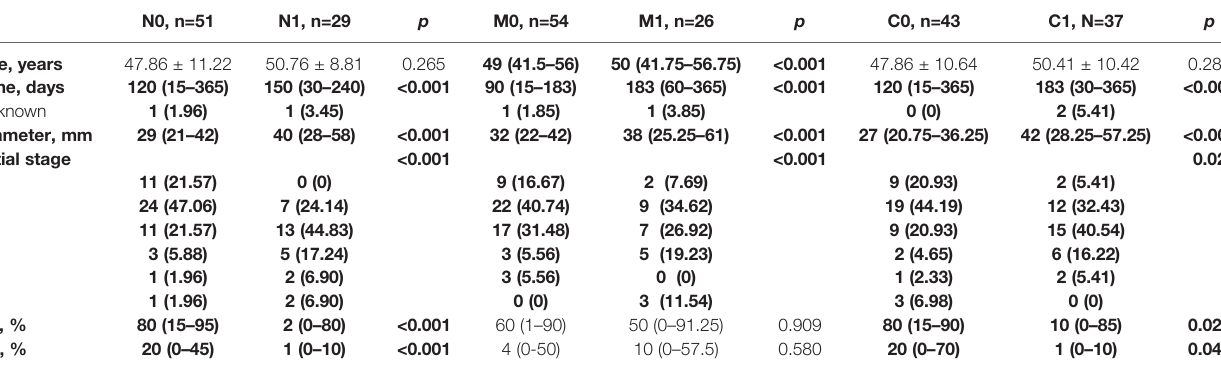
TABLE 1 | Descriptive characteristics of included breast cancer patients grouped by extraaxillary lymph node metastasis, distant metastasis, and unsuspected metastasis. N0,